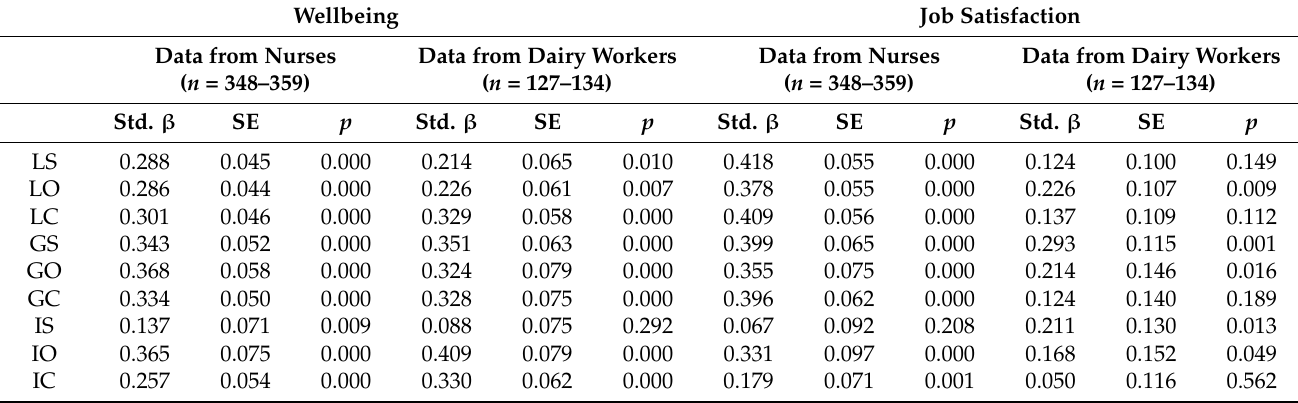
Table 4. Results from the regression analyses with wellbeing and job satisfaction respectively as outcome variable divided by the two